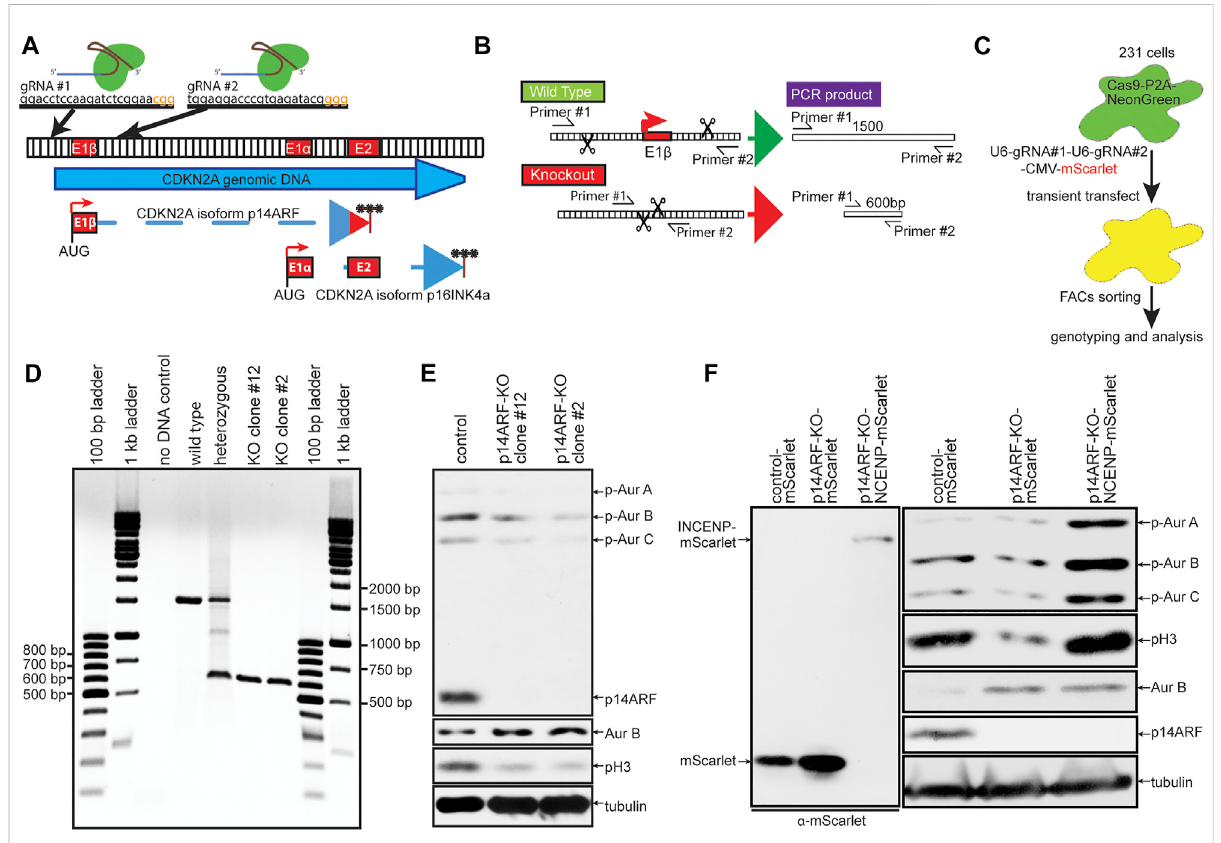
Expression of INCENP is suf fi cient to increase Aurora B activity in cells endogenously expressing elevated levels of Aurora B. (A – C) Schematic diagram of CRISPR-Cas9 p14ARF knockout (KO) strategy. (A) The CDKN2A genomic locus encodes for p14ARF and p16INKA. Two guide RNAs targeting exon1 β of CDKN2A were used to produce speci fi c p14ARF KO. (B) PCR strategy for con fi rming successful KO of p14ARF. (C) MDA-MB- 231 cells expressing Cas9-P2A-NeonGreen were transiently transfected with a construct expressing mScarlet and multiple guide RNAs and FACs sorted for mScarlet-NeonGreen double positive cells before genomic analysis for p14ARF knockout. (D) Double positive cells were screened using the PCR strategy in (B) . Homozygous KO clones show a 600 bp DNA band. (E) p14ARF KO clones 2 and 12 show complete KO of p14ARF by immunoblot, which induces constitutively elevated levels of endogenous Aurora B and lower levels of pH3. (F) p14ARF KO increases Aurora B and reduces phosphorylation of Aurora B and pH3. Expression of INCENP-mScarlet restores endogenous Aurora B kinase